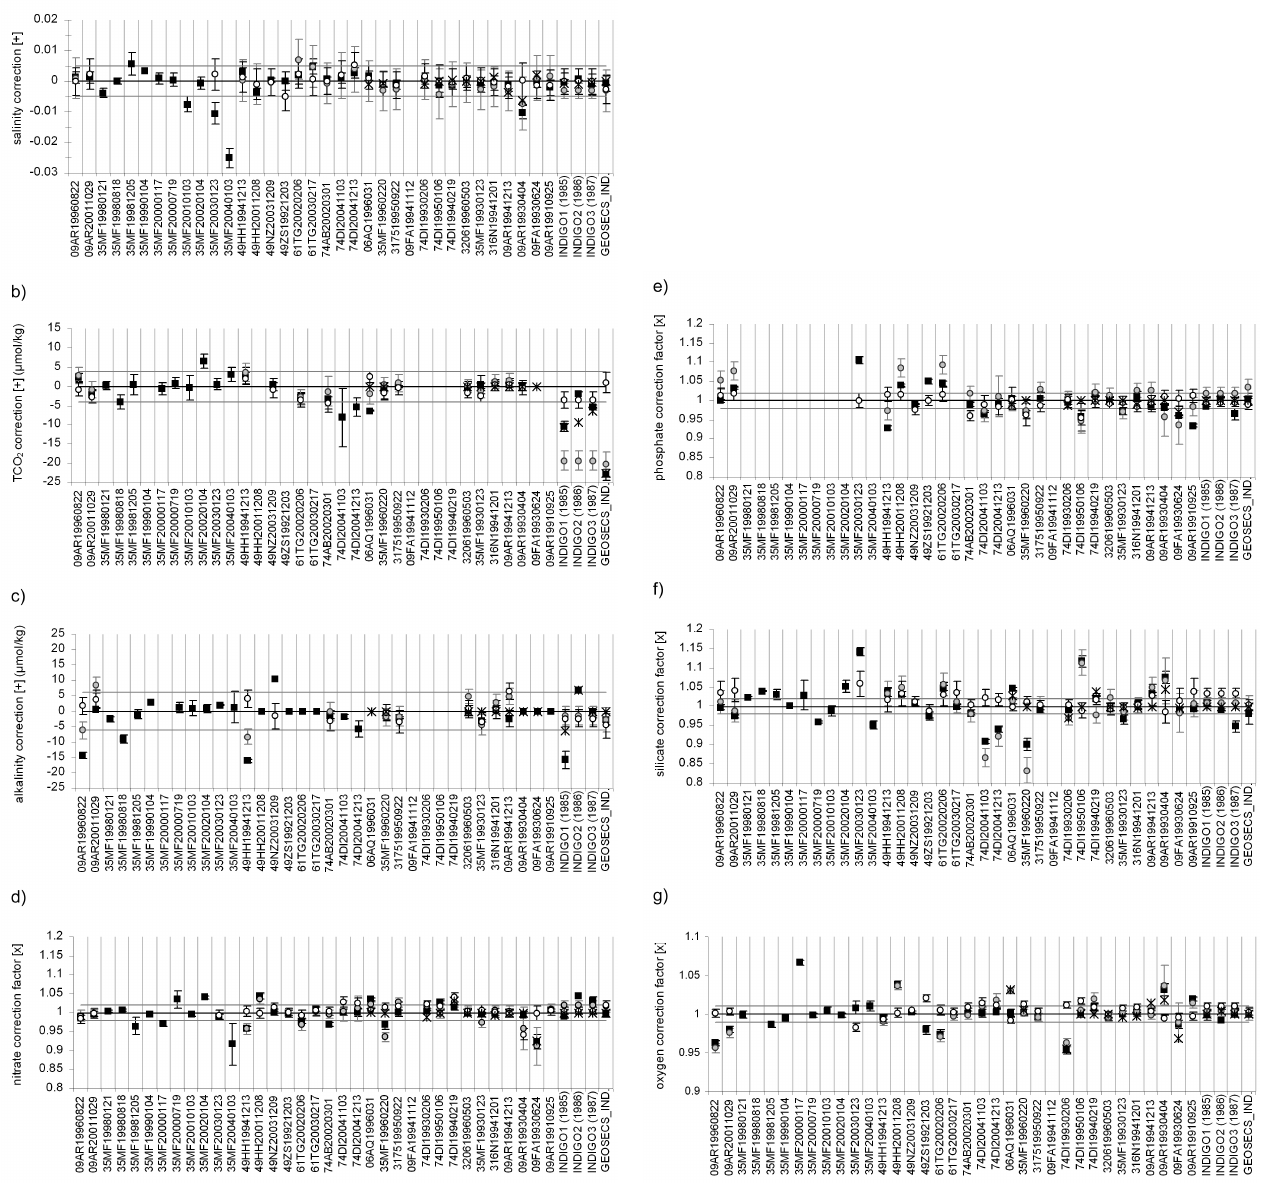
Figure 3. Corrections (additive) and correction factors (multiplicative) obtained from di ff erent methods for (a) salinity (b) TCO 2 , (c) alkalin- ity, (d) nitrate, (e) phosphate, (f) silicate and (g) oxygen. Results obtained with the WDLSQ inversion before and after data correction (gray and white dots, respectively) and from the regional analysis (black squares) are compared with previous estimates (GLODAP corrections, black crosses). Only adjustments above a defined threshold were considered for correction (salinity: 0.005, TCO 2 : 4 µ mol / kg, alkalinity: 6 µ mol / kg , nutrients: 2% and oxygen: